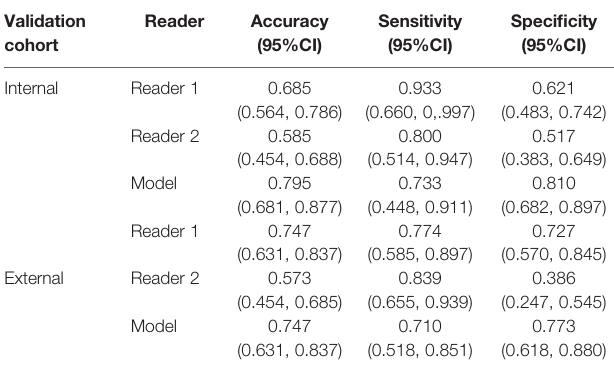
TABLE 3 | Performance of two radiologists and the deep learning model on validation cohorts. Validation